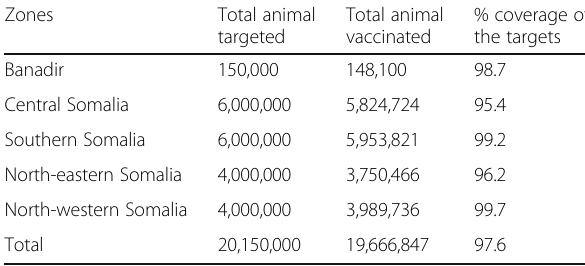
Table 5 Analyses of PPR vaccination coverage in sheep and goats in the five zones of Somalia, 2012